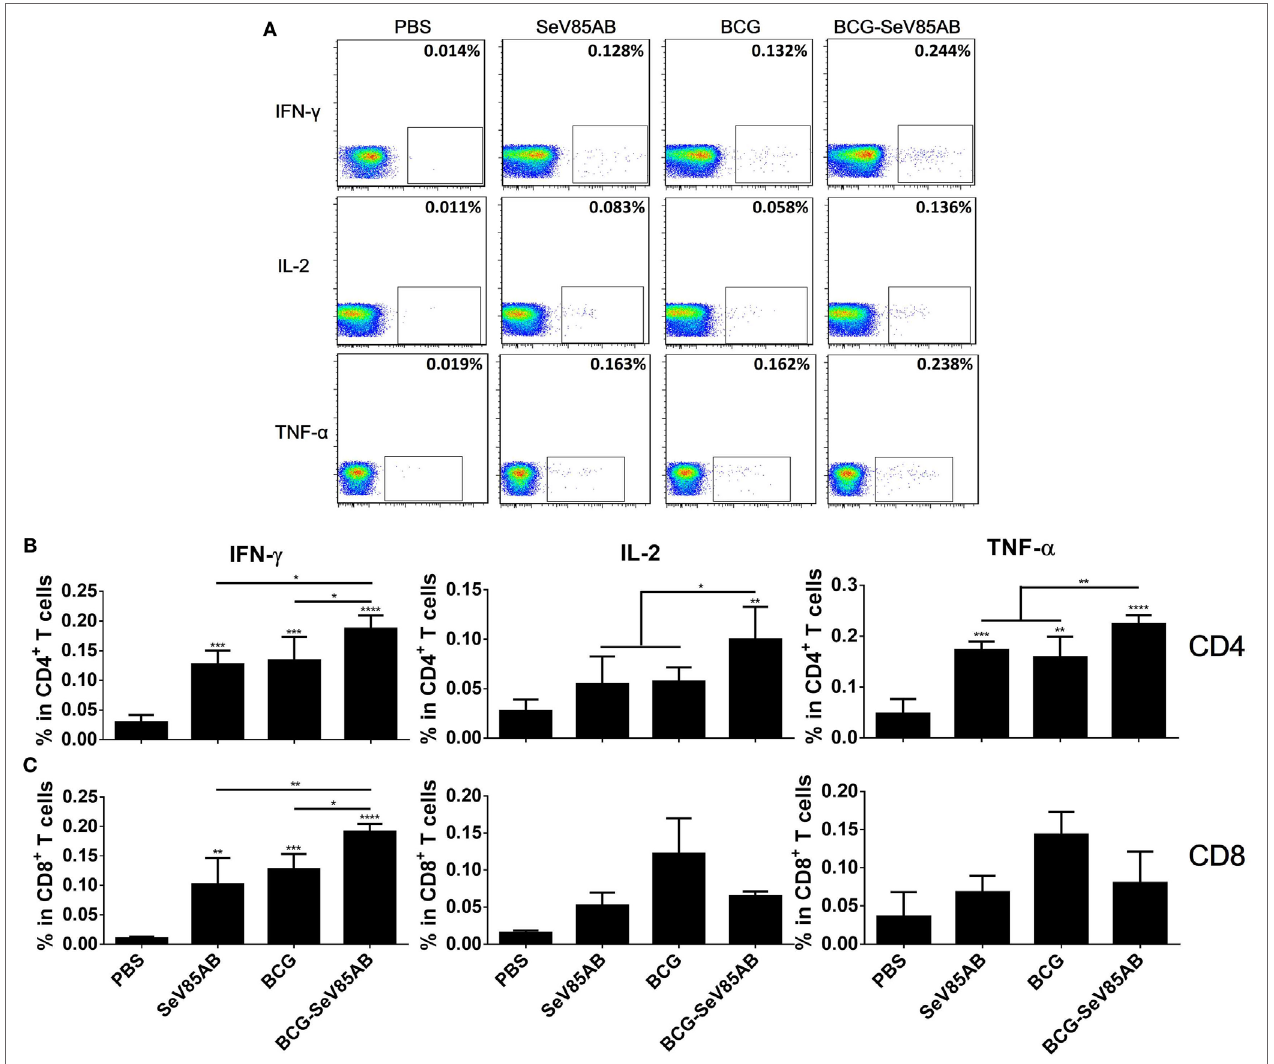
FigUre 2 | Flow cytometric analysis of ICS in the splenocytes of vaccinated mice. Splenocytes were collected 4 weeks after the last inoculation, incubated with Ag85AB peptides (5 µg/ml) in the presence of monensin and brefeldin A, and analyzed for cytokine production by ICS assay. CD3 + CD4 + cells (CD4 + T cells) and CD3 + CD4 − cells (CD8 + T cells) producing IFN- γ , IL-2, and TNF- α were analyzed. Representative flow cytometric plots of intracellular staining in CD4 + T cells are shown in (a) , and summary data of single cytokine producing CD4 + T cells (B) and CD8 + T cells (c) are shown with significant differences indicated. Data are representative of two independent experiments with at least four mice per group. * P < 0.05, ** P < 0.01, *** P < 0.001, and **** P <